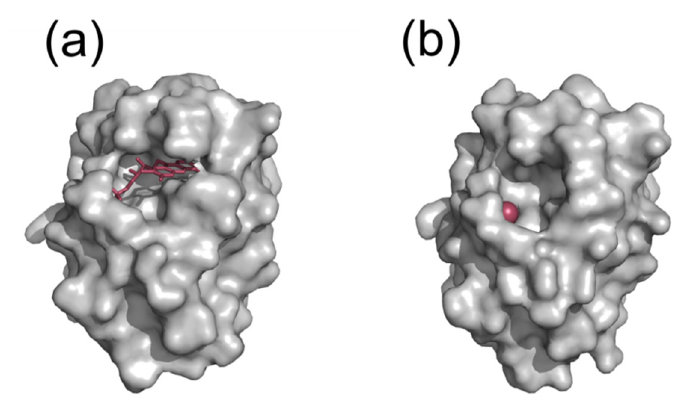
Figure 3. Molecular surface representation of holo ( a ) and apo ( b ) flavodoxin from Hp . FMN cofactor and a chloride ion bound at the FMN phosphate site are shown as red sticks and a sphere, respectively. The two structures are similar and exhibit an unusual pocket close to the cofactor binding site. Most other (apo)flavodoxins lack such surface pocket.